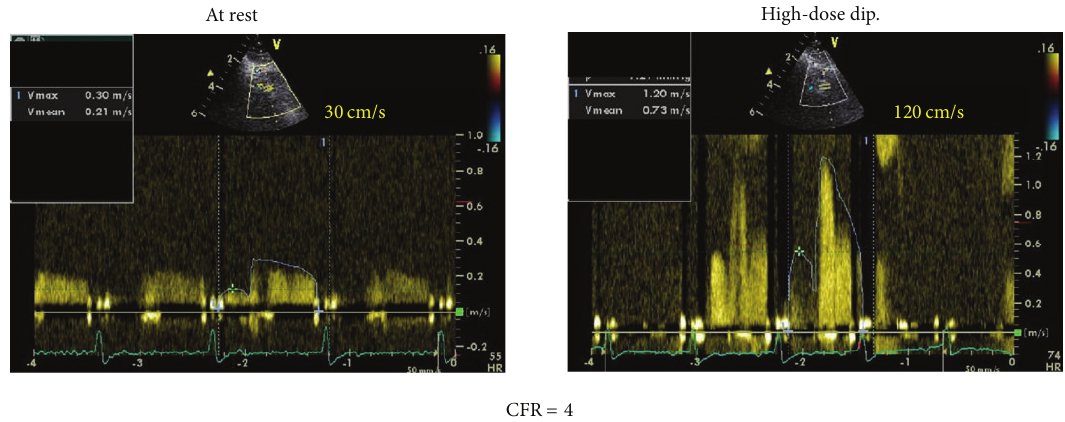
Figure 4: CFR evaluation after 6-month therapy with